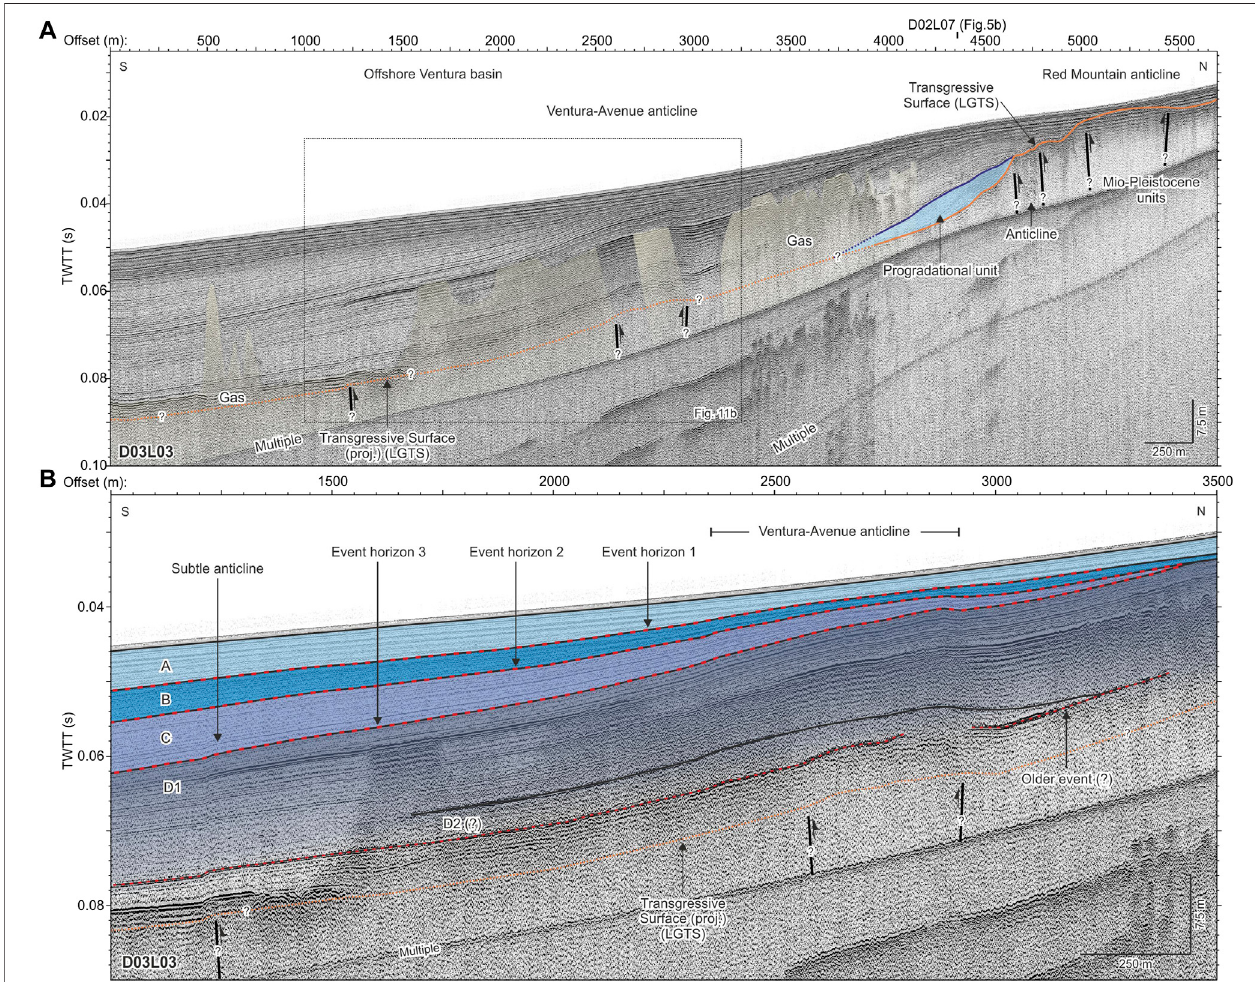
FIGURE 11 | (A) Interpreted CHIRP dip pro fi le D03L03 showing the folding of the Last Glacial transgressive surface (LGTS; continuous orange line) related to the offshore Red Mountain anticline and of the Holocene units related to the Ventura-Avenue anticline. The light blue unit bounded by a blue line corresponds to a progradationalunit.Thelocationofthepro fi leisshownin Figures2 , 3 . (B) Locationofenlargementisshownbytherectanglein Figure11A ,whichimagesthefoldingof the Holocene units that may be related to the offshore Ventura-Avenue anticline. Different seismostratigraphic units (A – D) based on stratal geometry are identi fi ed. Thereddashedlinesidentifyhorizonscorrespondingtodifferentdeformationevents(i.e.,Inferredearthquakes).Thecontinuousblacklinecorrespondstoare fl ectorthat appears to onlap on asurface below pointing to a possible old event on the anticline. The LGTS (dashed orange line) is projected from the structural contour map as itis not well imaged due to acoustic gas wipe out. Uninterpreted pro fi les are provided in Supplementary Figure S9 .